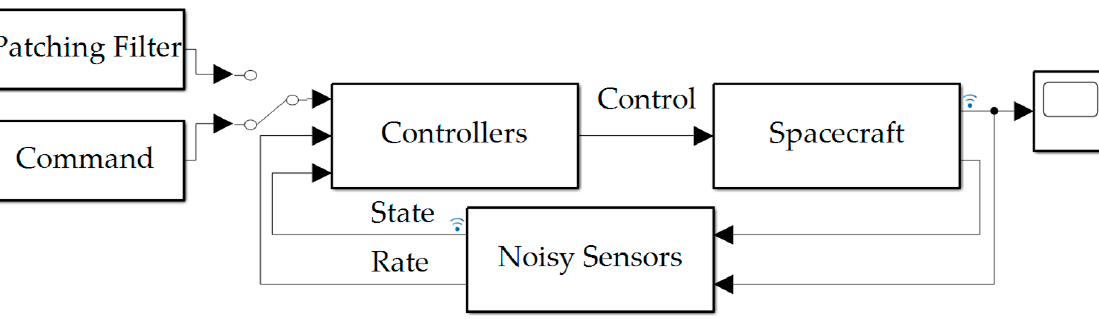
Figure A2. Pre- fi ltering simulation topology. Figure A3. Controllers’ simulation topology. Figure A4. P+V controller topology. Figure A5. Open-loop optimal controller topology.